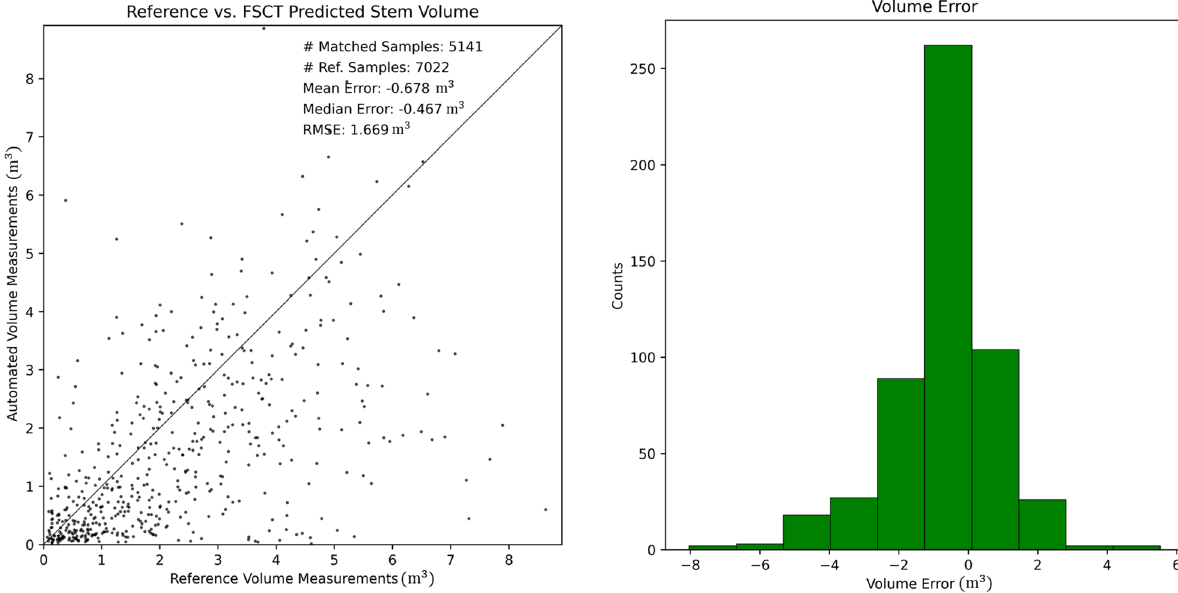
Figure 15. Left shows a scatter plot of automatically extracted volume estimates versus a single stem profile-based reference volume. Right provides a histogram to visualise the distribution of the volume measurement errors.